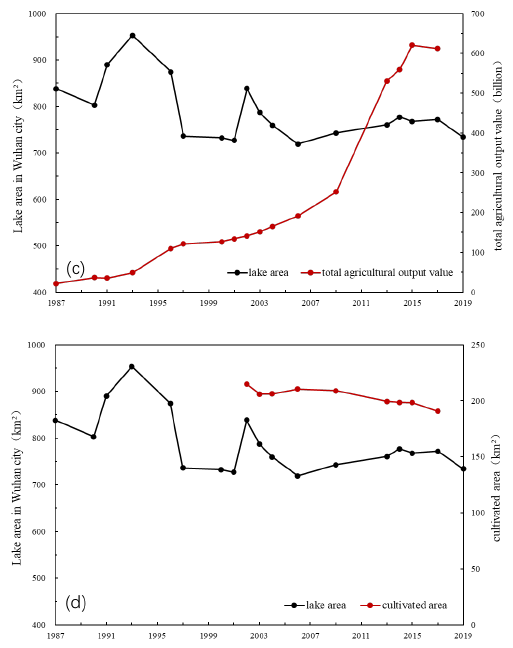
Figure 6 . (a) Correlation between permanent population and lake area (r=-0.48); (b) Correlation between GDP and lake area (r=-0.33); (c) Correlation between total agricultural output value and lake area (r=-0.37); (d) Correlation between cultivated area and lake area